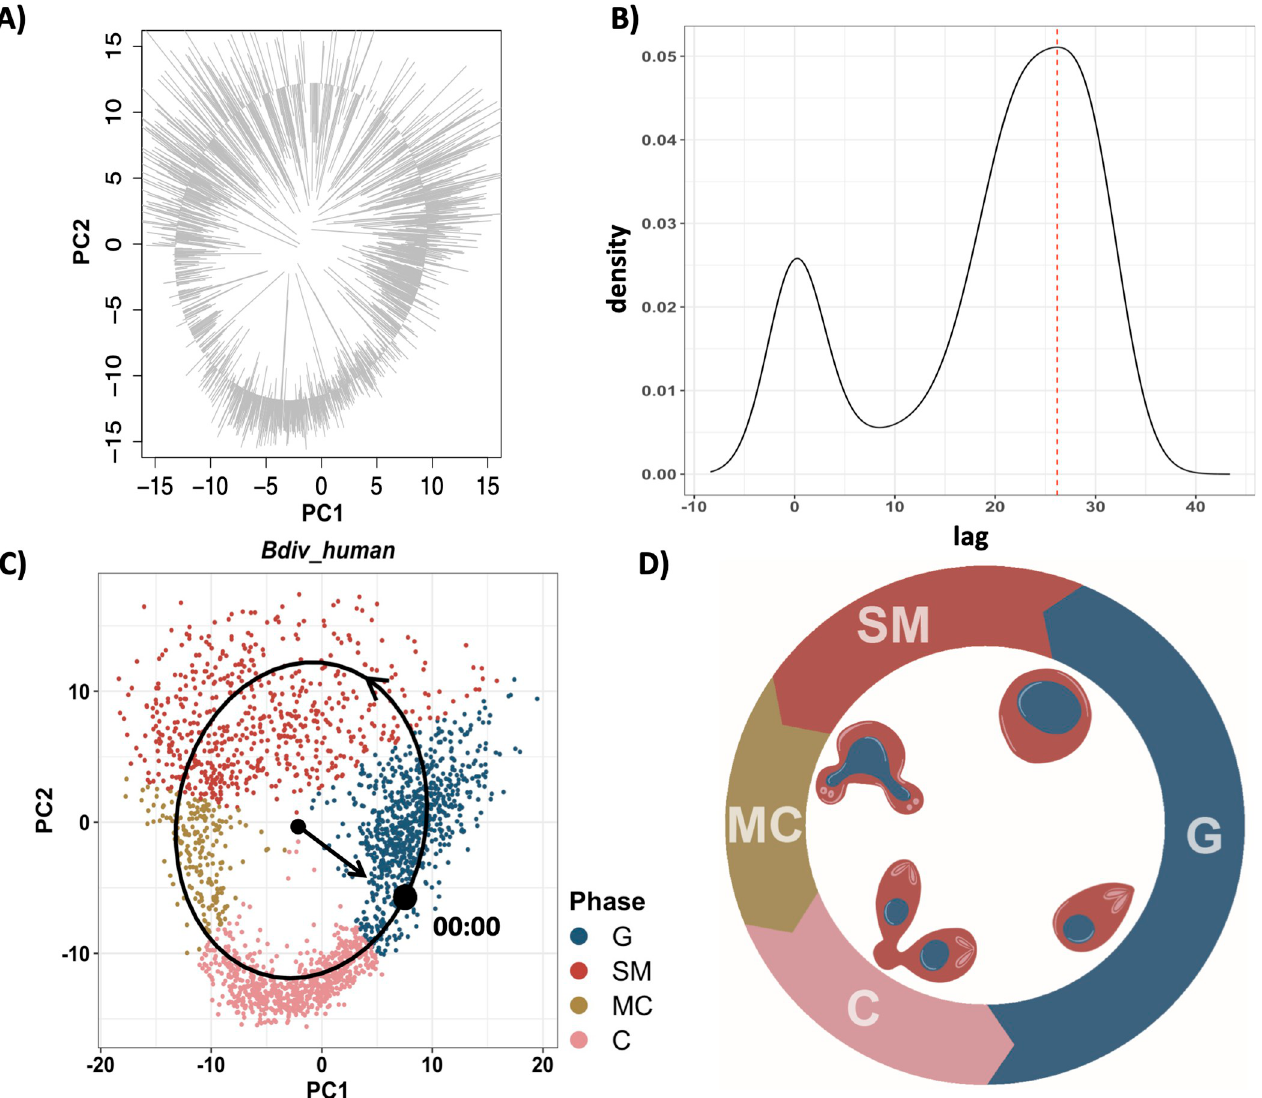
Fig 2. Pseudo-time reconstruction. (A) Cells were orthogonally projected on the elliptic principal curve fitted to the first 2 PCA coordinates and ordered sequentially using a random start point. The pseudo-time gene curve was constructed by mapping the cell orders to 0–12 h. (B) Distribution of the lag time between pseudo-time gene curves and matched gene curves from synchronized bulk measurements. Lag time was calculated using cross-correlation. The bimodal distribution AU : InthelegendforFig 2 : Pleasecheckthattheeditstothesentence } Thebimodaldistribution ::: } captureyourmeaning : Ifnot ; pleaseprovidecorrectwording : indicates 2 optimal lag times corresponding to monotonic curves (lag 0) and cyclic curves (red dashed line). (C) PCA plot of B . divergens in human RBCs. Start time (black dot) was adjusted according to the optimal lag time corresponding to the larger peak in (B). The black arrow on the principal elliptic curve indicates the flow of time. Transition points were mapped to the PCA coordinates in B . divergens in human RBCs, and the colors represent each inferred phase. (D) Schematic representation of the Babesia spp. cell division cycle in RBCs. PC, principal component; PCA, principal component analysis; RBC, red blood cell. Data and code for generating the figure are available at https://github.com/umbibio/scBabesiaAtlases.